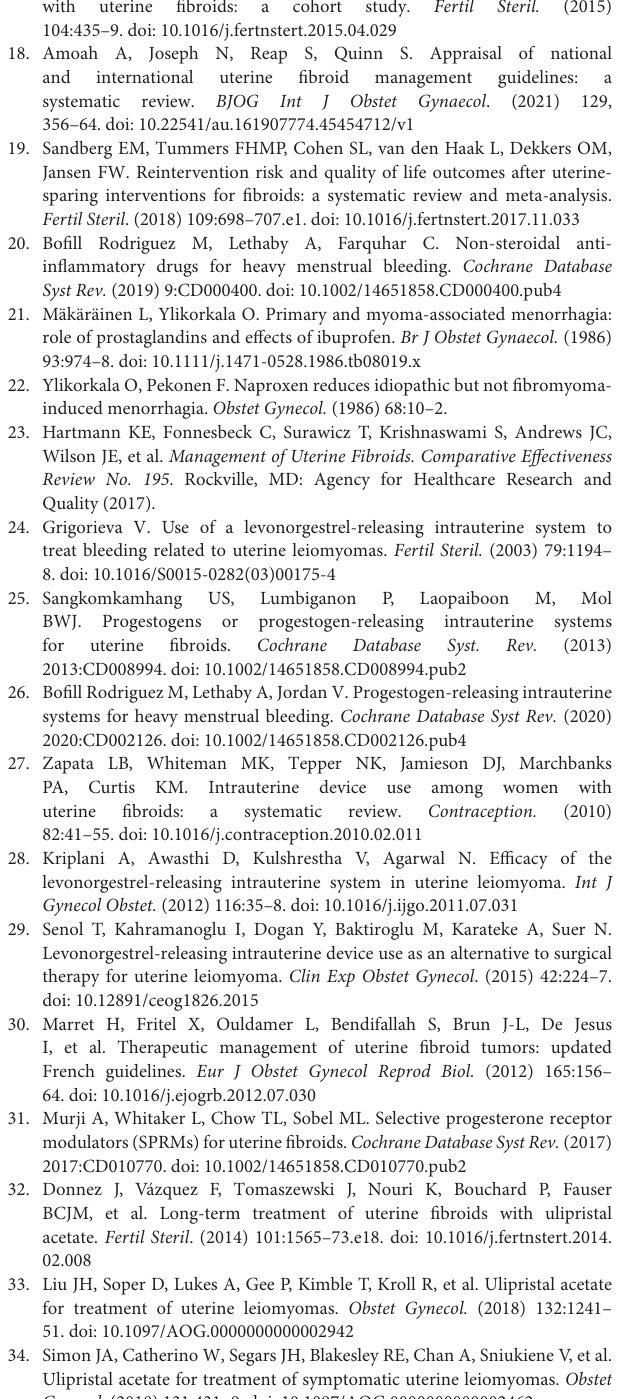
The figure was created with help from Biorender